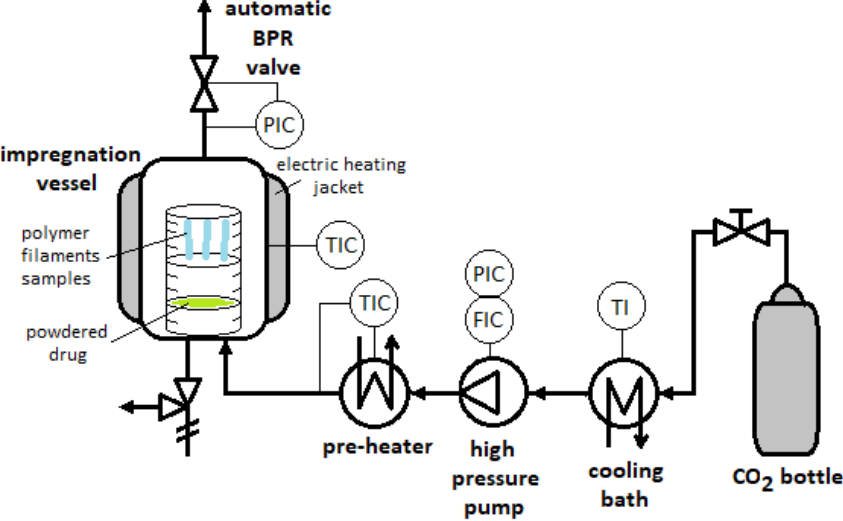
Figure 1. Flowchart of the supercritical solvent impregnation experiments.